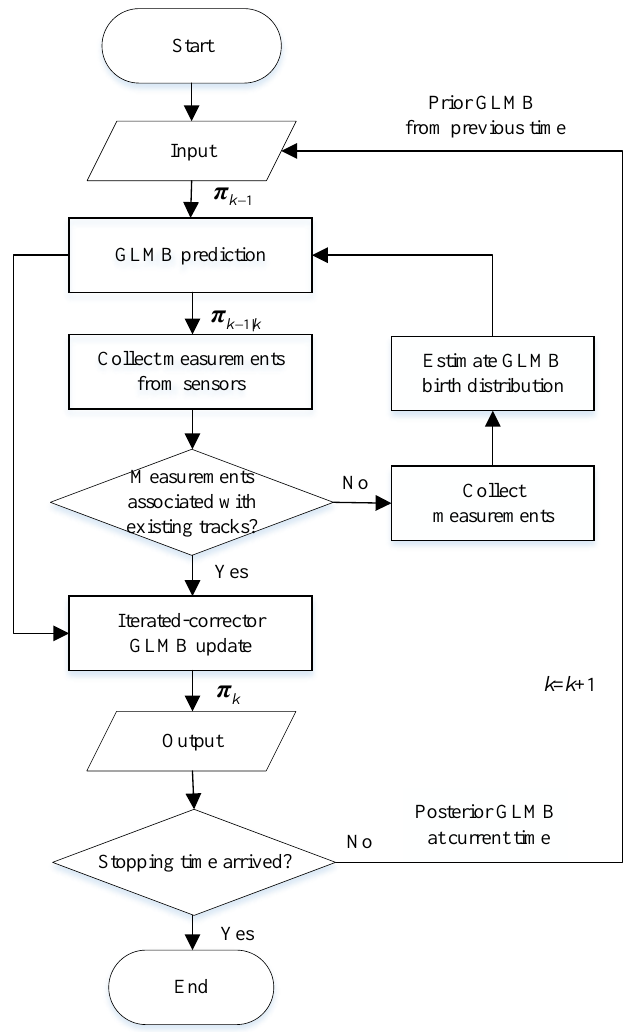
Figure 6. Flow chart of the CAR-GLMB